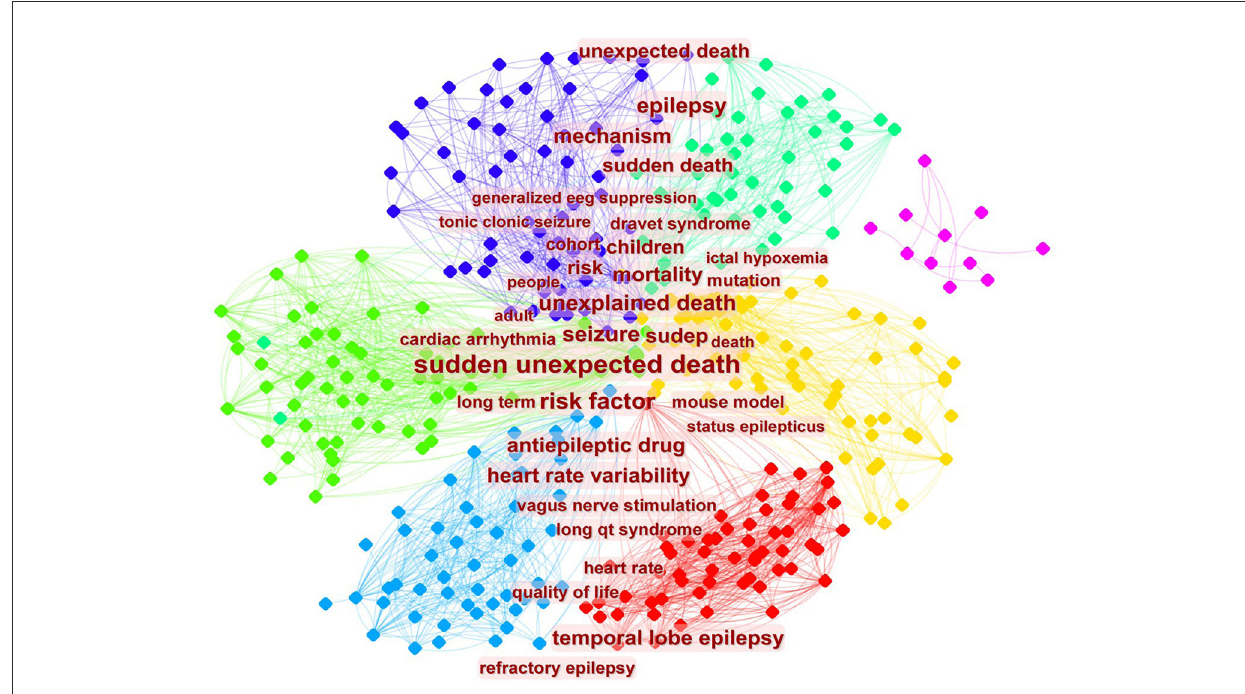
FIGURE7 Co-occurrence map of